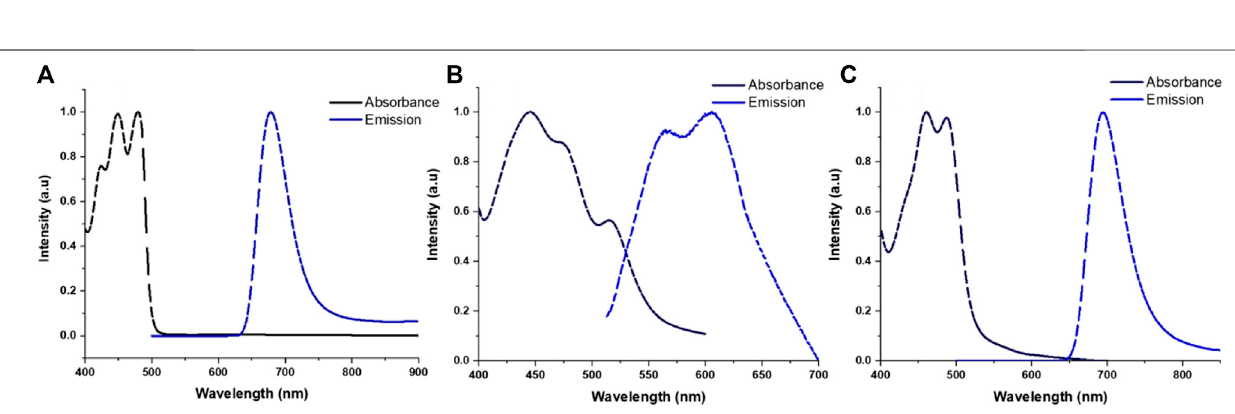
Frontiers in Chemistry |